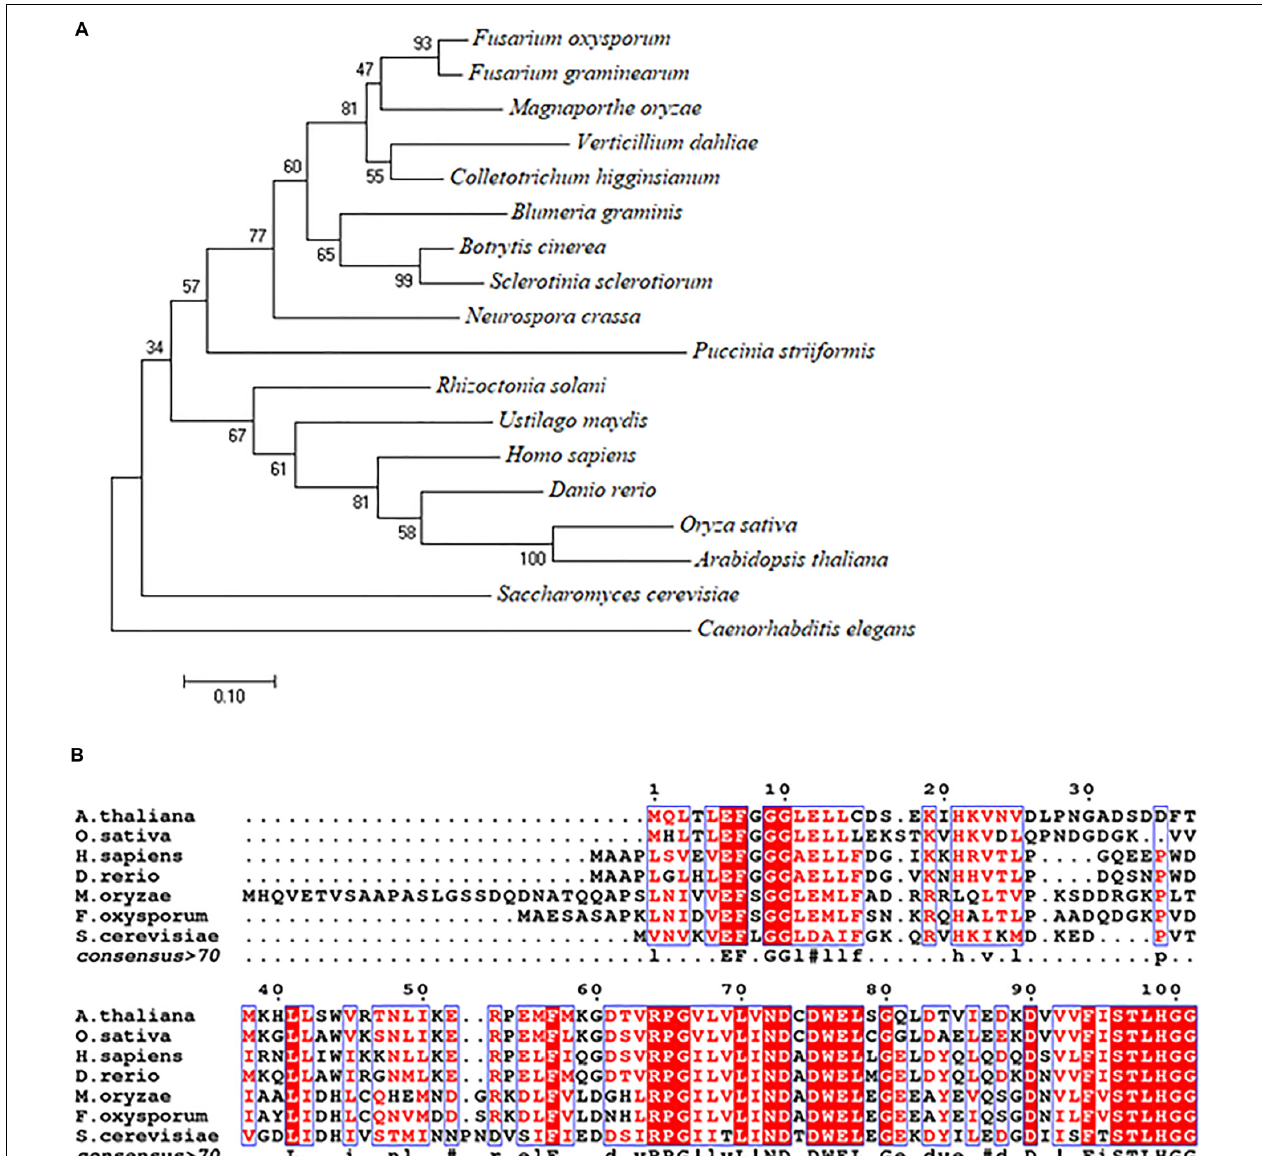
FIGURE 1 | Phylogenetic tree and alignment analyses of the URM1 proteins. (A) A phylogenetic tree of the URM1 amino acid sequences in different species. Numbers at nodes indicate the bootstrap values. Scale bar indicates the number of amino acid differences per site. (B) Alignment of the amino acid sequences of URM1 from M. oryzae and other selected model organisms. Amino acid sequences were aligned with ClustalW (http://www.ch.embnet.org/software/ClustalW.html). Identical residues are colored by red regions, and similar residues are colored by red